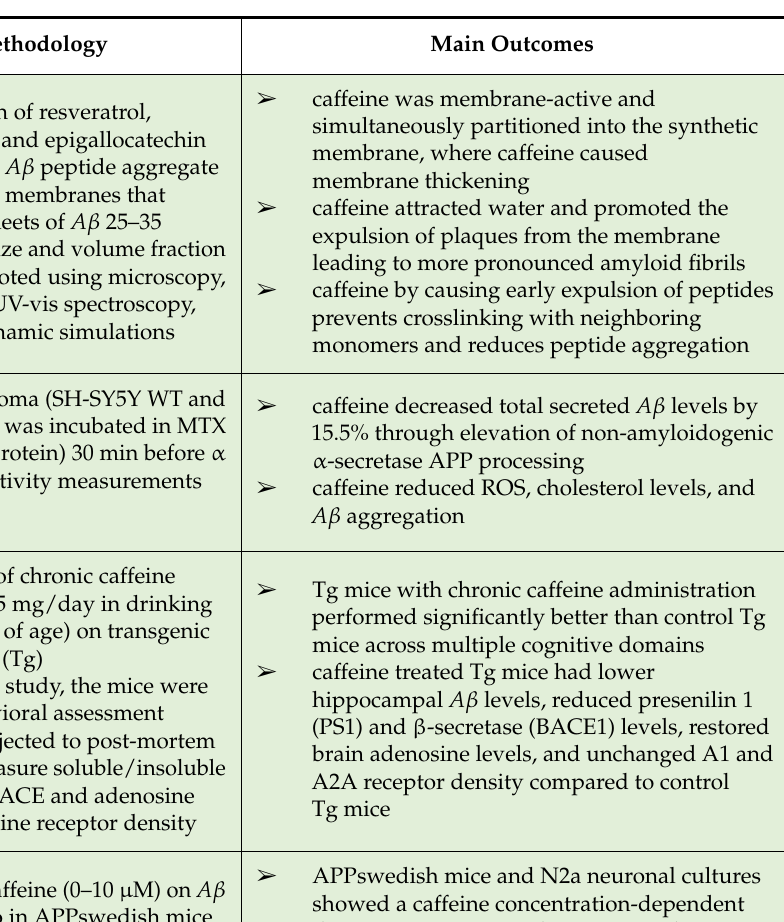
Table 2. In vitro and in vivo studies